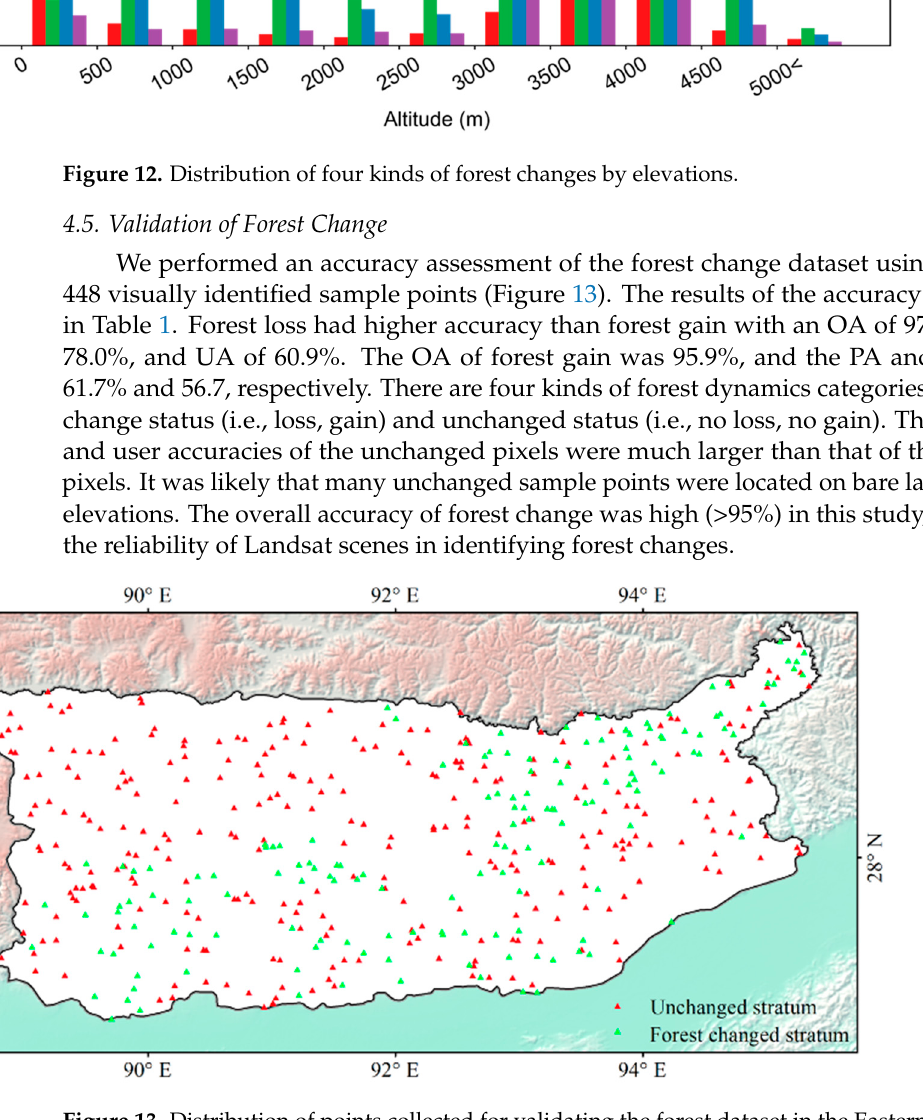
Figure 12. Distribution of four kinds of forest changes by elevations.